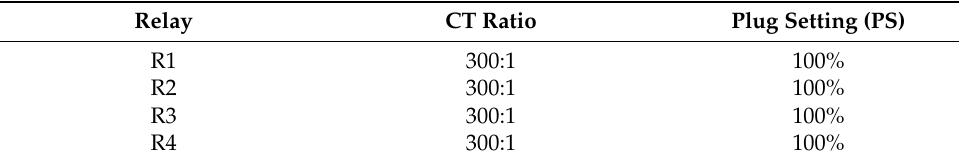
Figure 3. A single-ended power system with parallel feeders. Table 1. Plug settings (PS) and CT ratios of the relays (Case 1).